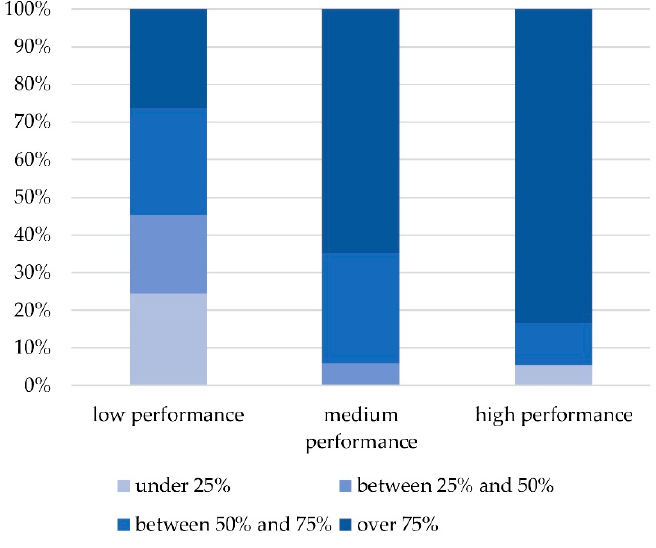
Figure 12. Shares of occupancy of individual office spaces by performance category (last six months).